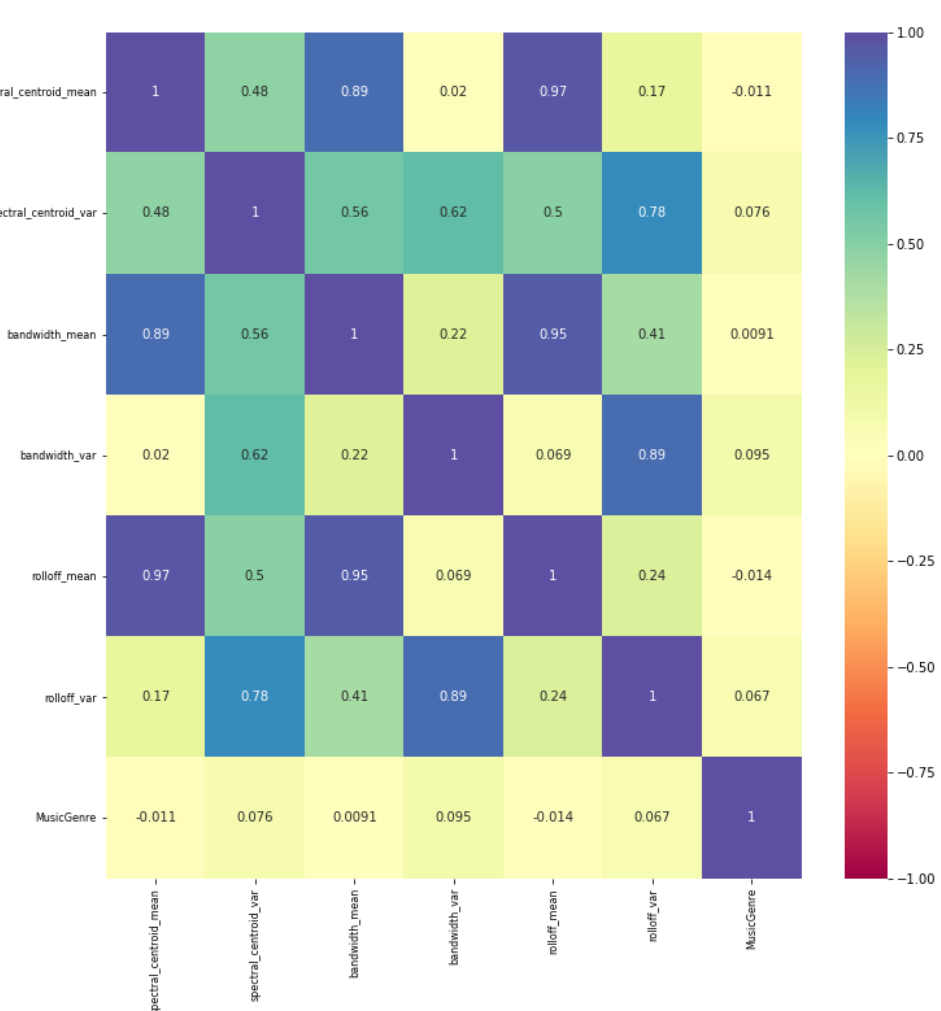
Figure 11. Correlation matrix for spectral features (independent variable) and label (target